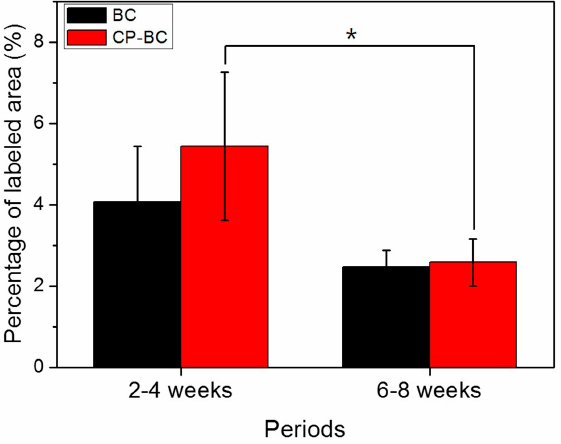
Figure 8. Percentage of mineralized area labeled by calcein green in relation to the determined area at different periods in defects exposed to untreated (BC) or treated (CP-BC) biphasic grafting materials. * Significantly different between groups ( p < 0.05).